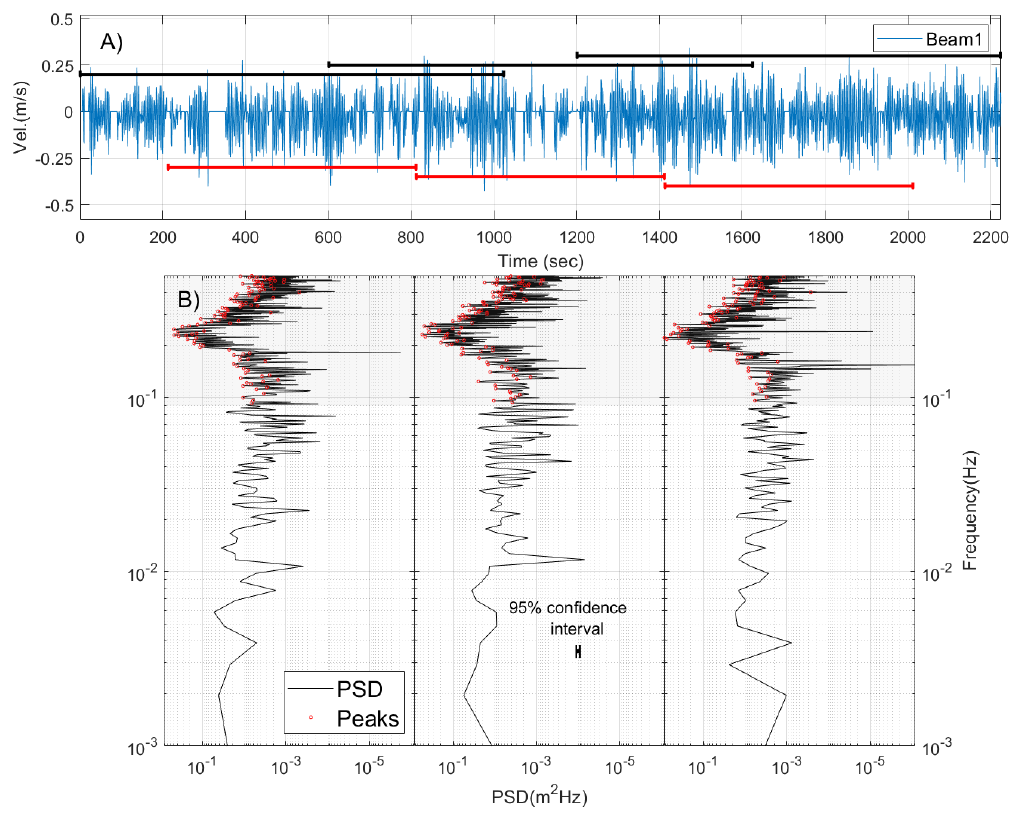
Figure 2. ( A ) Beam1 velocities at 9.04 m above the bottom (blue line) during a 37-min segment. Data windows to compute Power Spectral Density (PSDs) (m 2 / s, black lines), and ensembles used to calculate Reynolds stresses ( −𝒖 ′ 𝒘 ′ ̅̅̅̅̅̅ , red line). ( B ) PSDs calculated with the data windows denoted by black lines in (A); the shaded area indicates the frequency band in need of wave-bias removal. The red circles denote peaks at the frequencies identified to reconstrut wave signals.